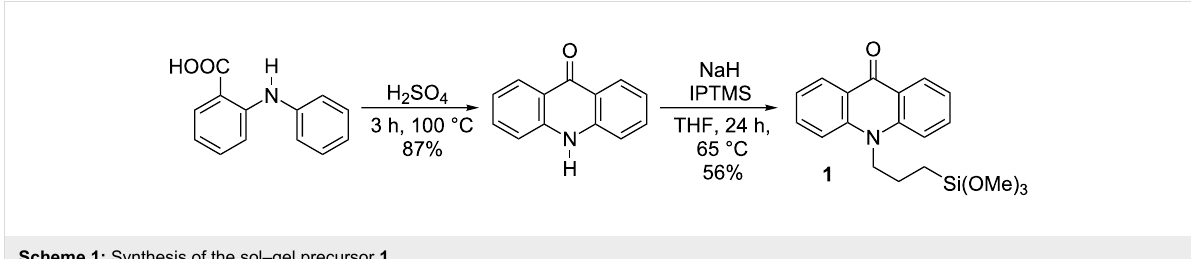
Scheme 1: Synthesis of the sol–gel precursor 1